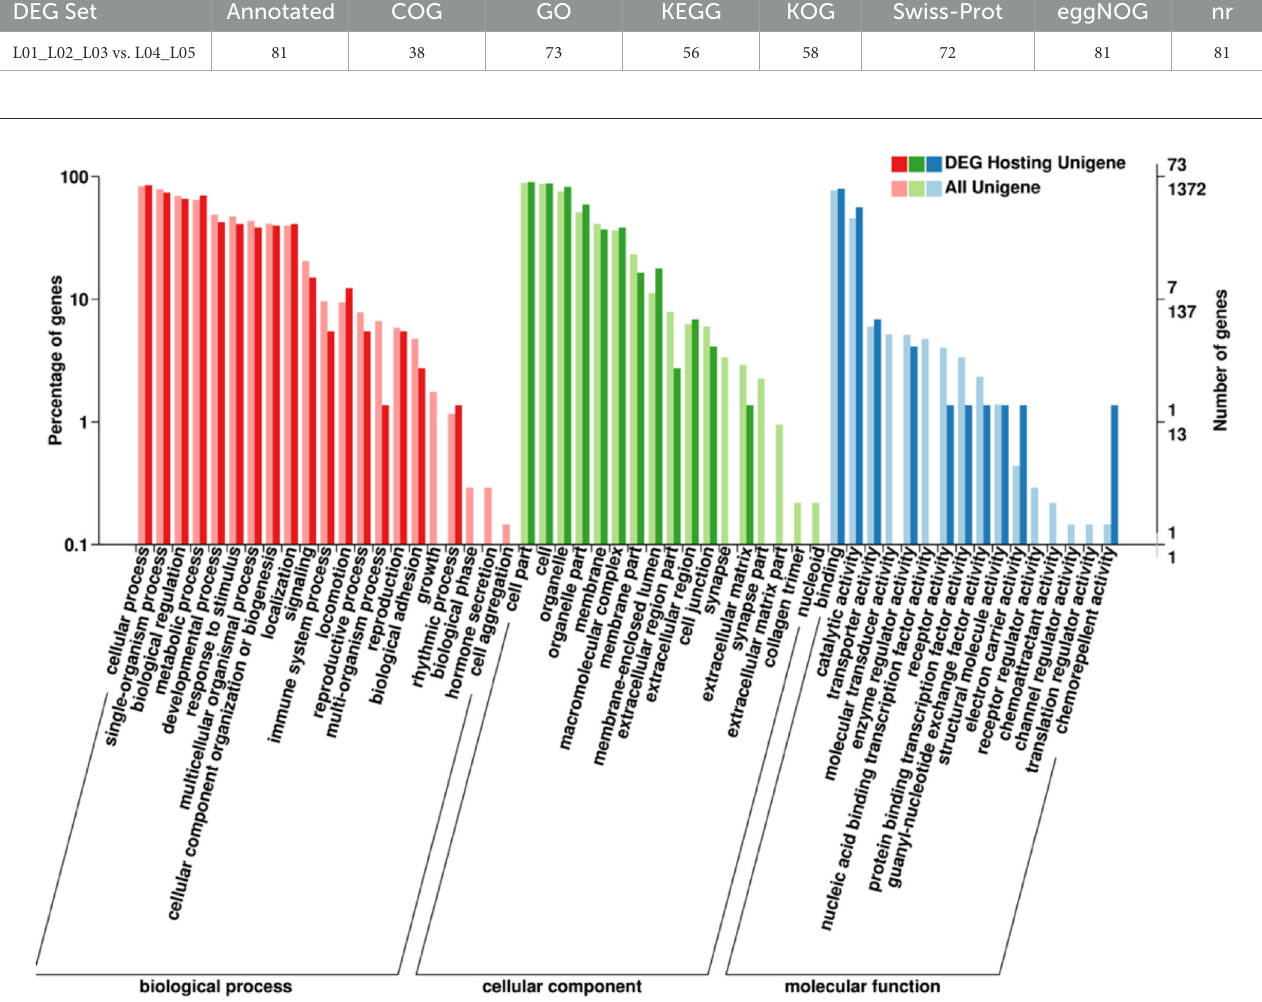
FIGURE7 Annotated statistical diagram of circRNA-derived Gene Ontology Consortium (GO) secondary nodes. The abscissa is the go classification, the left side of the ordinate is the percentage of the number of genes, and the right side is the number of